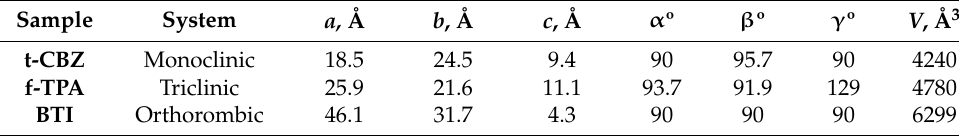
Table 2. Crystal cell parameters of t-CBZ , f-TPA and BTI